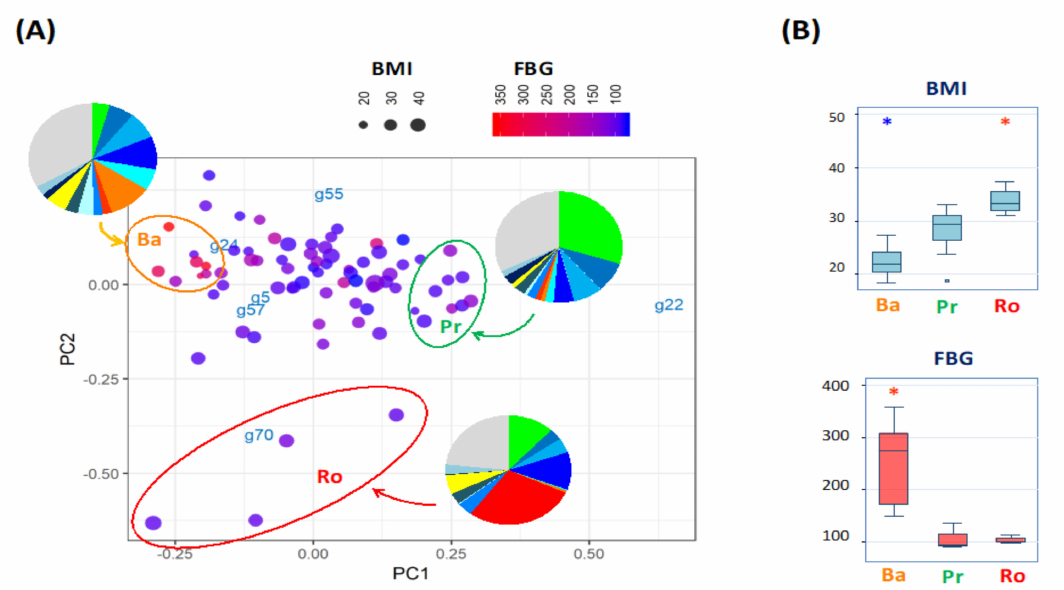
Figure 1. Fecal microbiome variation of the 75 Indonesian adults driven by three genera and their relation to obesity and diabetes. ( A ) Principal component analysis plot of the 75 microbiomes of Indonesian subjects. The sample ordination and genus loadings were calculated according to the genus composition of 75 stool samples. The BMI and FBG of each sample donor are represented by the dot size and color according to the indicated scales. The samples localized in each edge of these 75 samples ordination were selected and circled with the first two letters of the driving genera, namely Ba of Bacteroides , Pr of Prevotella , and Ro of Romboutsia . The genus composition was averaged within the circle and graphed in the pie charts. ( B ) Box plot of BMI and FBG in the three clusters. Red and blue asterisks represent statistically higher and lower than the other groups with p < 0.05 in the pairwise Wilcoxon rank-sum test with Bonferroni